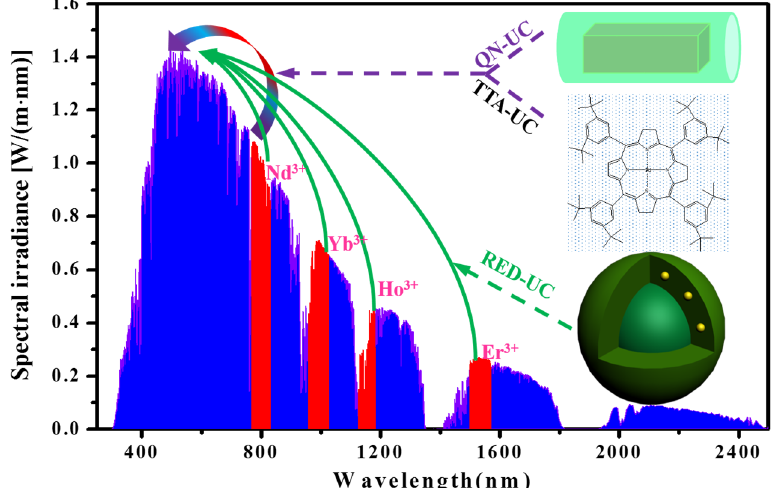
Figure 1. The absorption and emission range of three types of upconversion materials in reference to AM 1.5 spectrum (QN-UC (purple): upconversion in quantum nanostructures; TTA-UC (purple): triplet-triplet annihilation upconversion; RED-UC (green): Rare-earth-doped upconversion